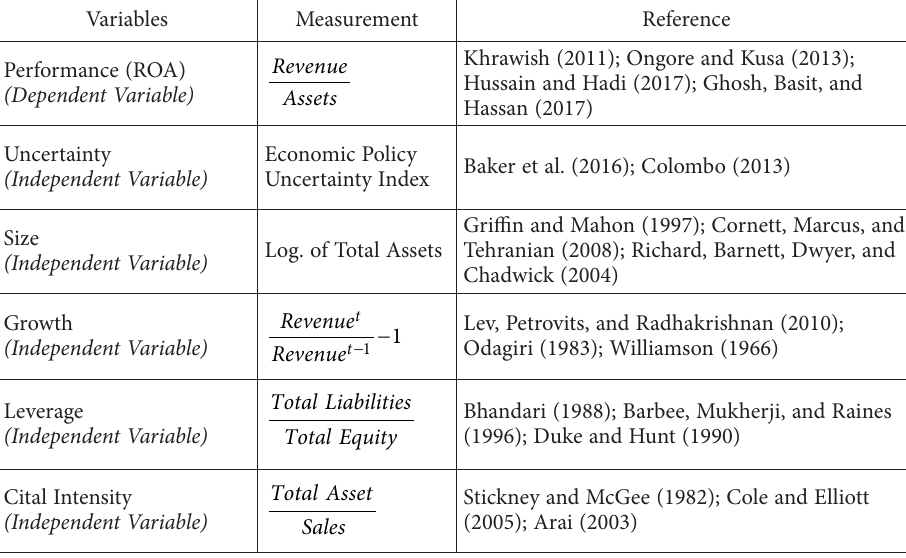
Table 1. Measures of dependent and independent variables Variables Measurement Reference Khrawish (2011); Ongore and Kusa (2013); Revenue Performance (ROA) Hussain and Hadi (2017); Ghosh, Basit, and (Dependent Variable) Assets Hassan (2017) Uncertainty Economic Policy Baker et al. (2016); Colombo (2013) (Independent Variable) Uncertainty Index Griffin and Mahon (1997); Cornett, Marcus, and Size Log. of Total Assets Tehranian (2008); Richard, Barnett, Dwyer, and (Independent Variable) Chadwick (2004) t Revenue Growth Lev, Petrovits, and Radhakrishnan (2010); − 1 (Independent Variable) − Odagiri (1983); Williamson (1966) 1 t Revenue Total Liabilities Leverage Bhandari (1988); Barbee, Mukherji, and Raines (Independent Variable) (1996); Duke and Hunt (1990) Total Equity Total Asset Cital Intensity Stickney and McGee (1982); Cole and Elliott (Independent Variable) (2005); Arai Sales